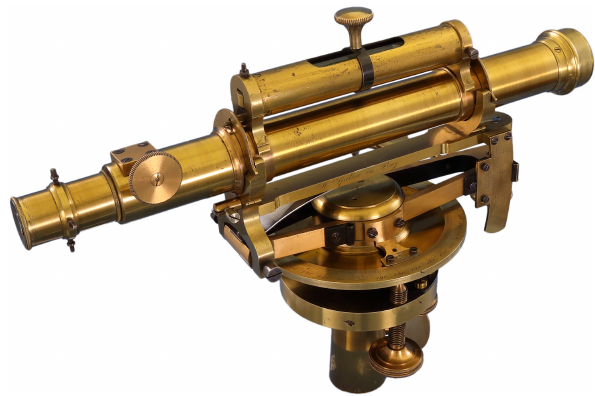
Figure 2. Levelling instrument by Spitra (photo supplied by https: //www.surveyinginstruments.org).